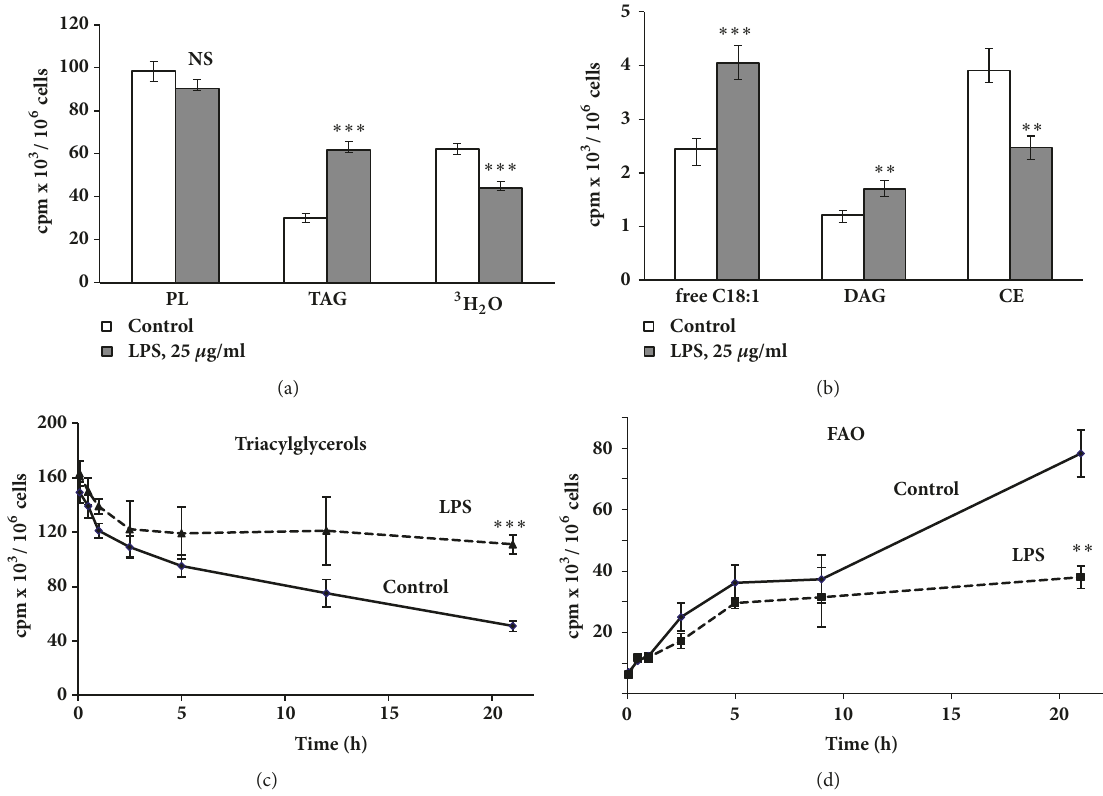
Figure 2: Incubation of FUBEC with LPS changes the distribution of [ 3 H]-C18:1 between lipid classes . (a, b) Effect of LPS on the metabolism of different lipid classes. PL: phospholipids, TAG: triacylglycerols, DAG: diacylglycerols, CE: cholesterol esters. (( c), (d) ) Time-course of the effect of LPS on [ 3 H]-TAG level and on [ 3 H]-C18:1 oxidation. Cells were preloaded with [ 3 H]- b 18:1 for 1 h and then rinsed and incubatedwith LPS (25 𝜇 g/ml, 21 h). At the end of the incubation, cells were harvested and total lipid extraction and TLC were performed. n=6 independent experiments. ∗∗ p < 0.01; ∗∗∗ p < 0.001 versus control.